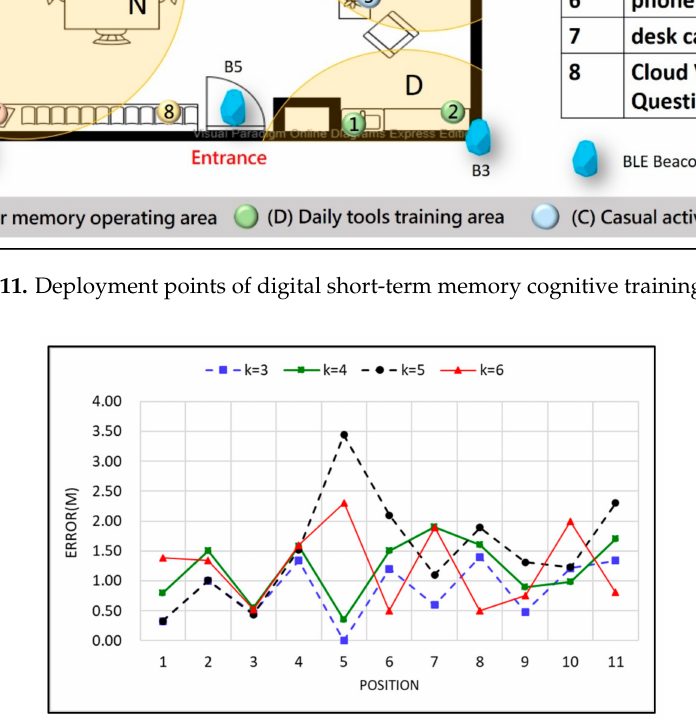
Figure 12. Positioning error